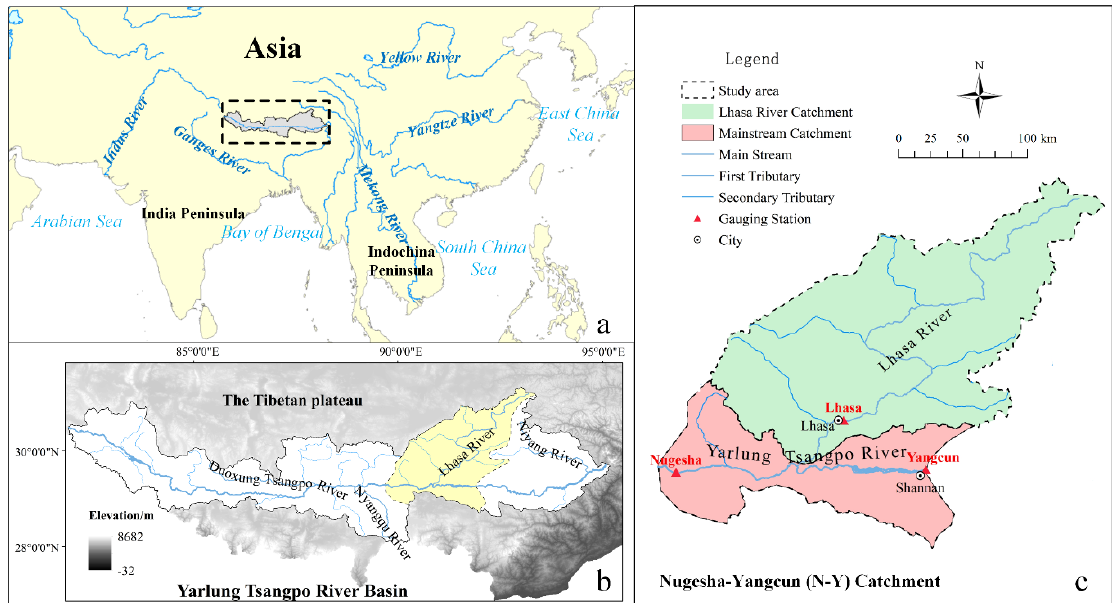
Figure 1. Map of the study area and hydrological station locations; a. the location of the Yarlung Tsangpo River basin against the Asia; b. the location of the Nugesha–Yangcun (N–Y) catchment and the main tributaries of the Yarlung Tsangpo River; c. the streams network in the N–Y catchment. Table 1. Basic information of the hydrological gauging stations.